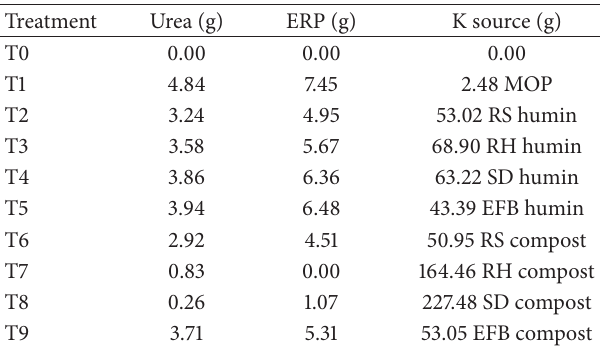
Table 2: Treatments evaluated in a pot experiment using Zea mays L. as test